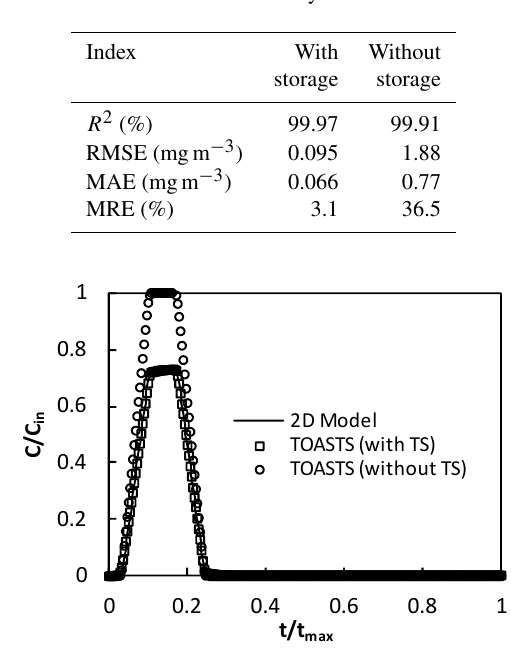
Table 5. Error indices of verification by the 2-D model.